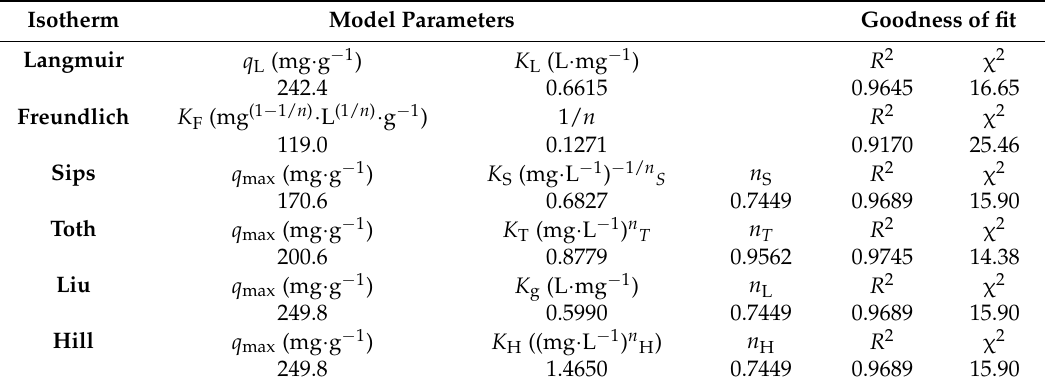
Table 4. Isotherm models that were fit for the adsorption of paraquat using the κ -carrageenan nanoparticles as the nanosorbent.